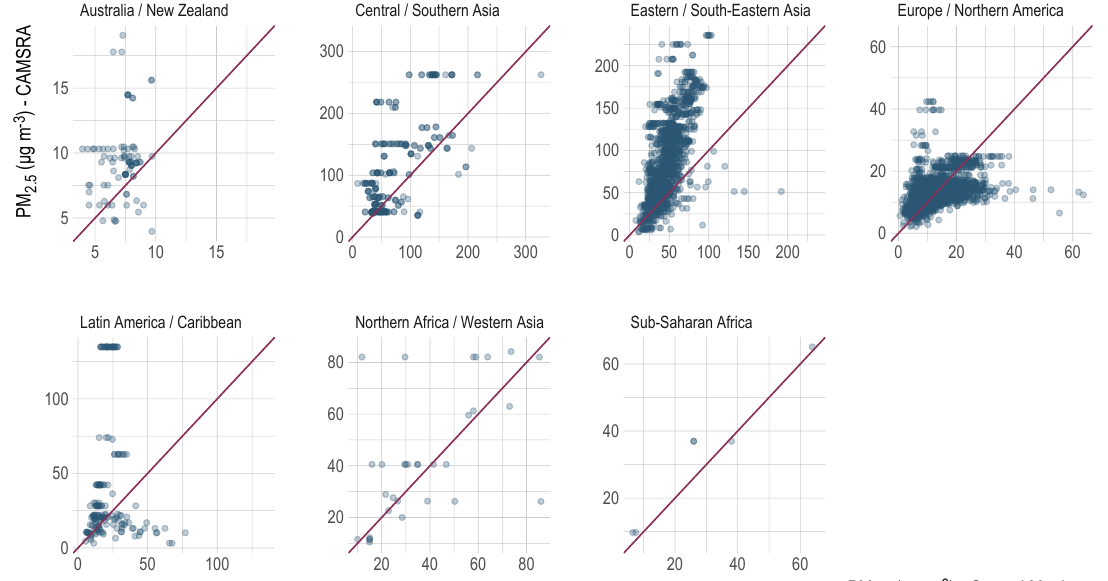
Figure 1. Comparison between the annual average of PM 2.5 estimated by the Copernicus Atmosphere Monitoring Service multi-annual global reanalysis of atmospheric composition and ground measurements, by Sustainable Development Goals (SDG) region, for 2016. Red lines indicate a one-to-one